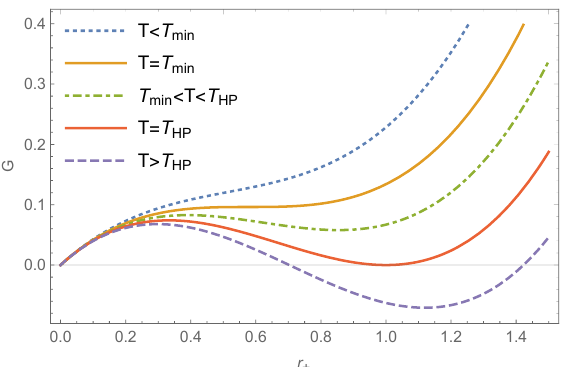
Figure 1 . Free energy landscapes for Hawking-Page phase transition. The generalized Gibbs free energy is plotted as the function of black hole radius r + at different temperature. In discussing Hawking-Page phase transition, we set the AdS curvature radius L as